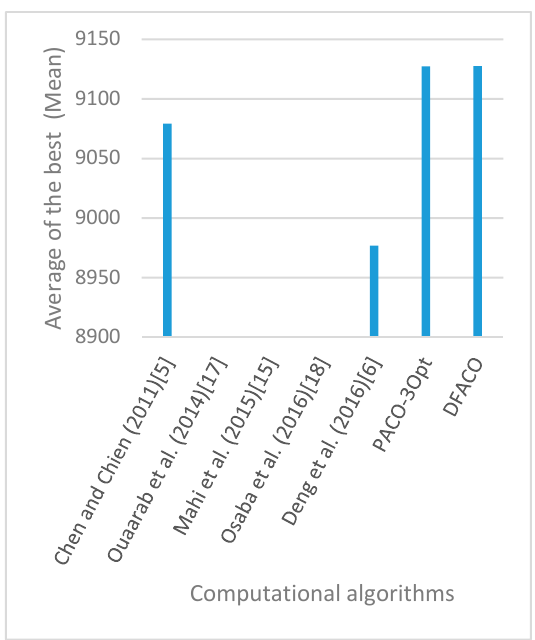
Figure 28. Average of best solutions obtained for instance rat783 by all algorithms.